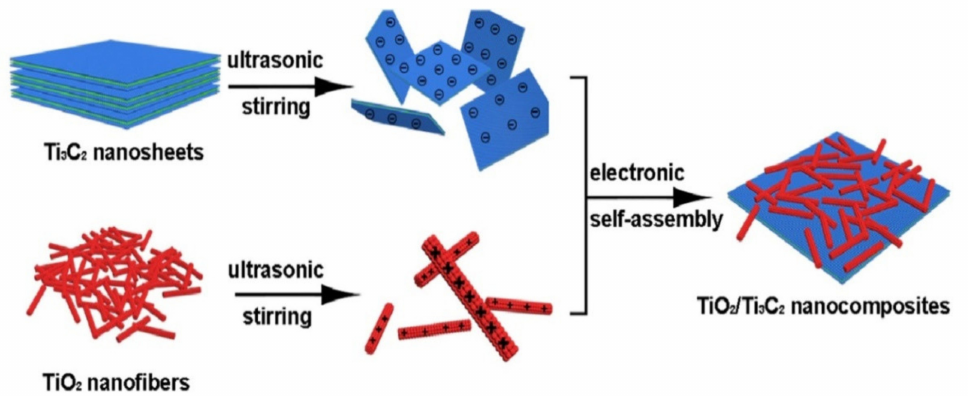
Figure 5. Schematic illustration displaying procedure for fabrication of TiO 2 / Ti 3 C 2 T x composite. Reproduced with permission from reference [67]. Copyright Elsevier B.V.,